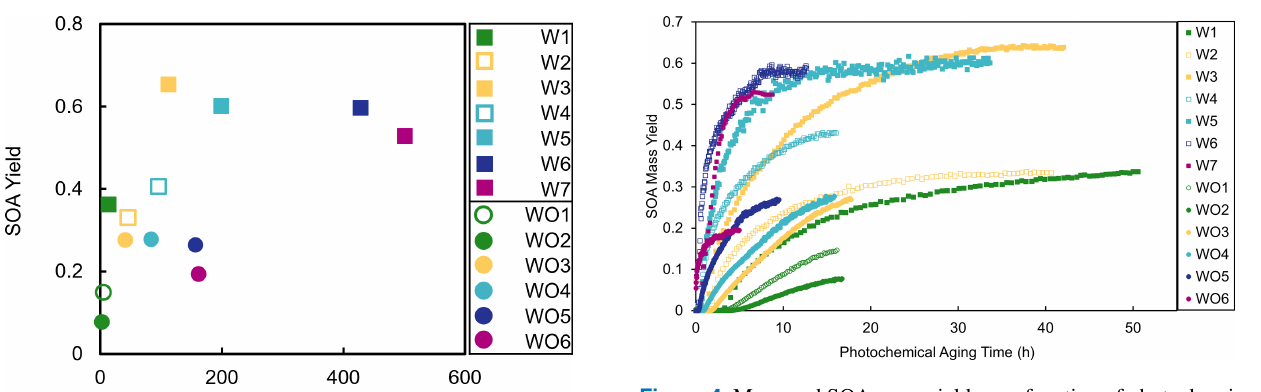
Figure 4. Measured SOA mass yields as a function of photochemi- cal aging time in experiments with added NO x (squares) and exper- iments without added NO x